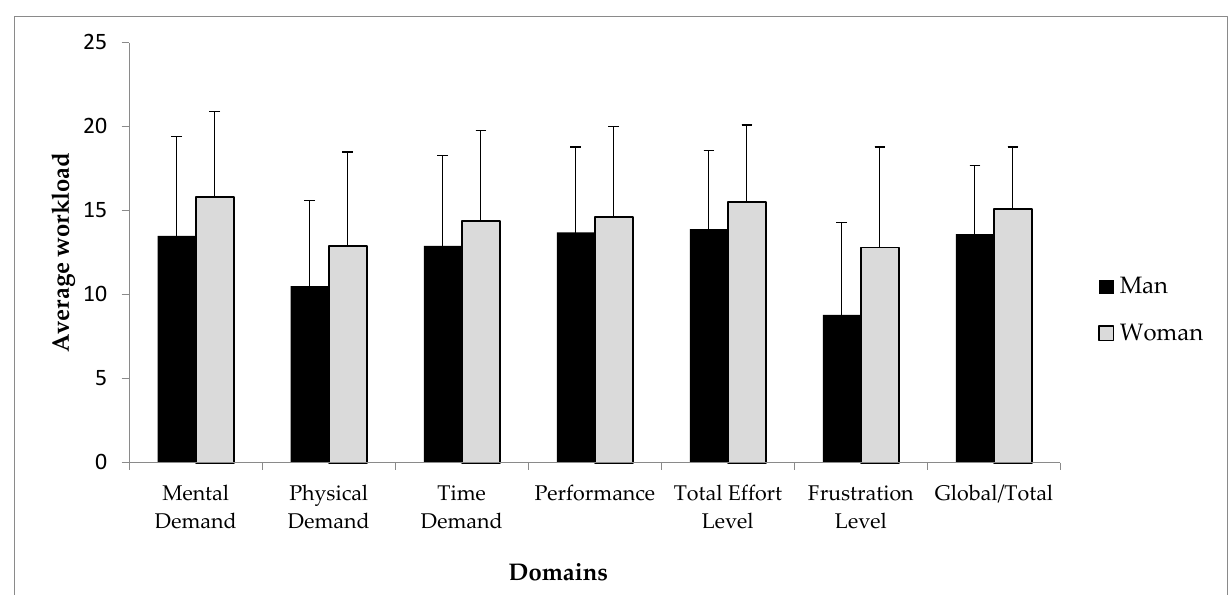
Figure A2. Averages of the workload domains according to the professional’s gender. Error bars represent standard deviation.